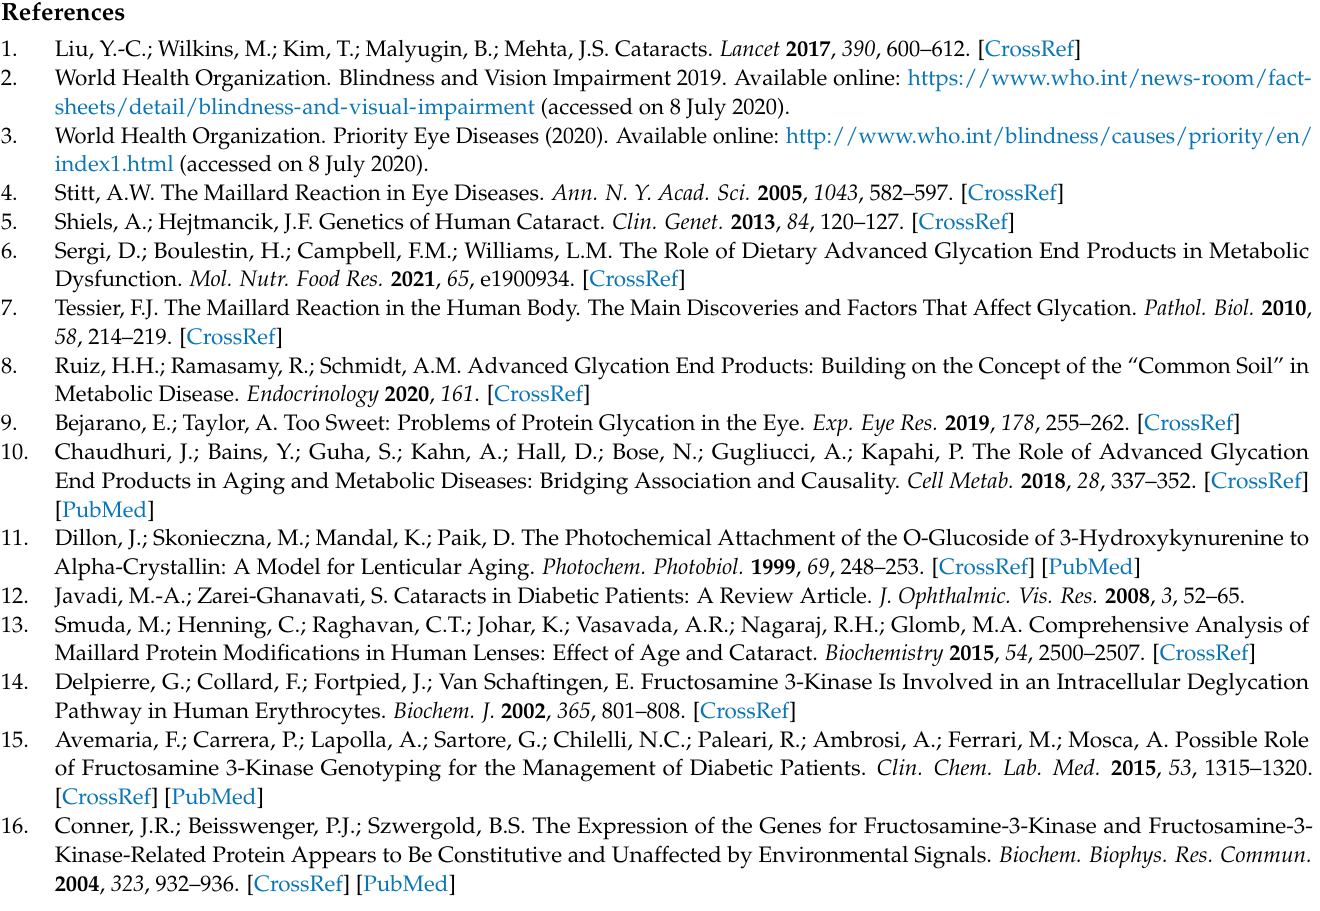
Figure A2. Time-dependent changes (%) in autofluorescence (AF) values after treatment of a catarac- tous human lens suspension (different suspension as the one used in Section 4.7.2 “Kinetics of FN3K treatment”) with 20 µ L of a solution containing fructosamine-3-kinase (FN3K, 125 µ g/mL) and its cofactors ATP (12.5 mM) and MgCl 2 (5 mM) in PBS, (2) the cofactors solely and (3) a solution containing ADP solely (12.5 mM). The experiments were performed in duplicate using the same setup as described in Section 4.7.2. While clear decreases in AF values were observed for the FN3K enzyme, slight increases in AF values were noticed for the solutions containing ATP/MgCl 2 and ADP. Based on these results, we could conclude that neither the added ATP nor the ADP that was not released by the mutant enzyme was responsible for the observed decreases in autofluorescence after FN3K treatment in our